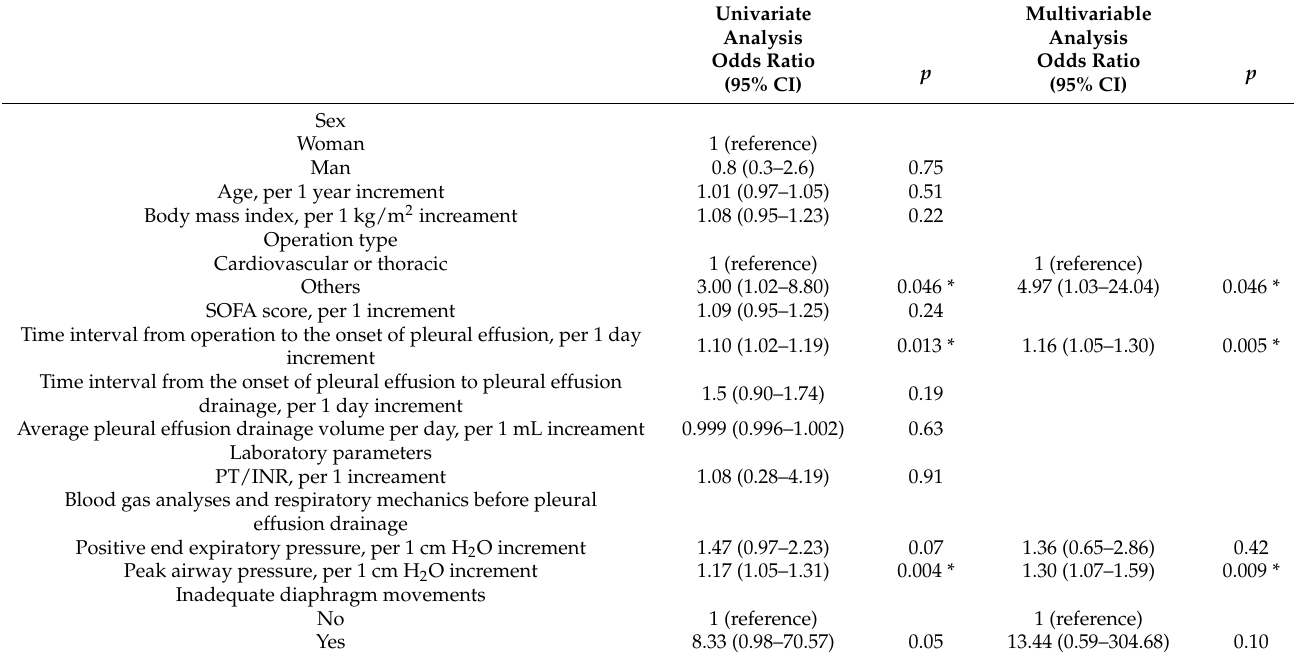
Table 3. Univariate and multivariable logistic regression analysis of adverse predictors for being free from mechanical ventilation within 72 h after pleural effusion drainage.